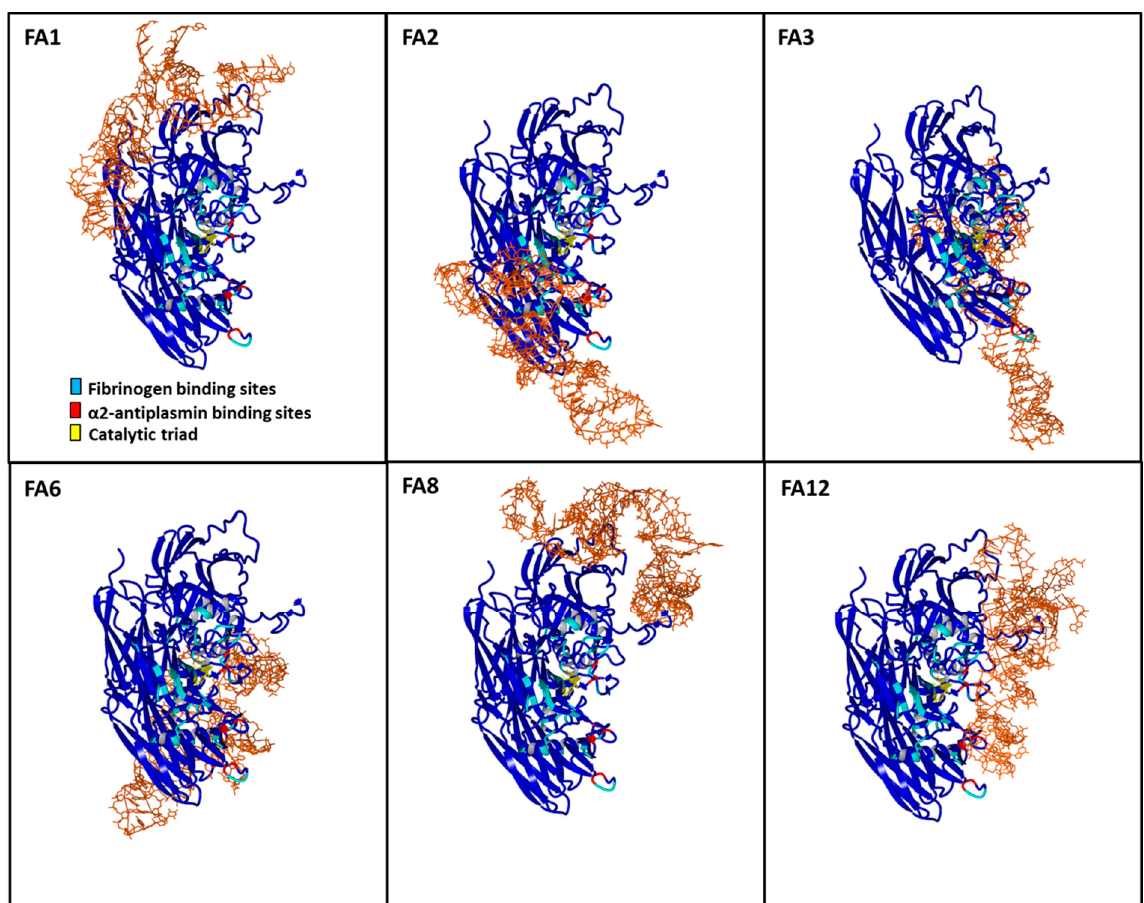
Figure 4. Aptamer docking on FXIIIa. The highest scoring docking pose for each of the six aptamers on FXIIIa is illustrated. The aptamer models are colored brown and represented in stick format while the FXIIIa backbone is represented in blue colored ribbon format. The fibrinogen and α 2AP binding sites on FXIIIa, based on a previous docking study have been colored cyan and red, respectively [36]. The catalytic triad residues on FXIIIa are colored yellow.